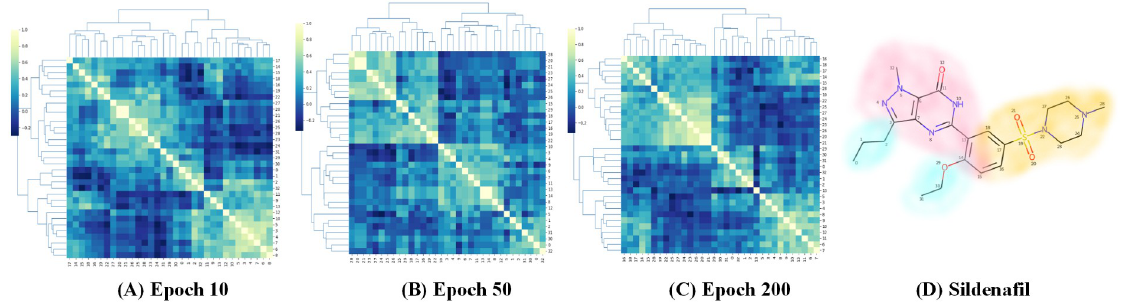
Fig 7. Heat maps of the atom similarity matrix for drug sildenafil.